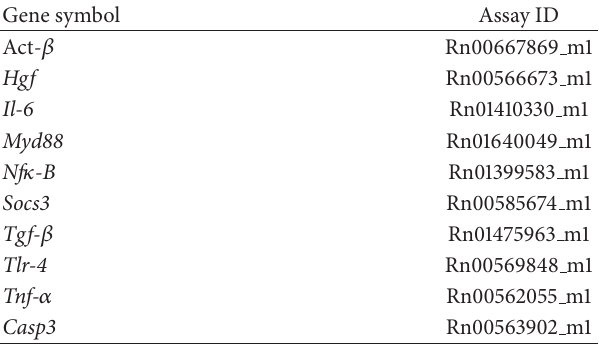
Table 1: TaqMan (Life Technologies, USA) ID assays for genes analyzed in this study.